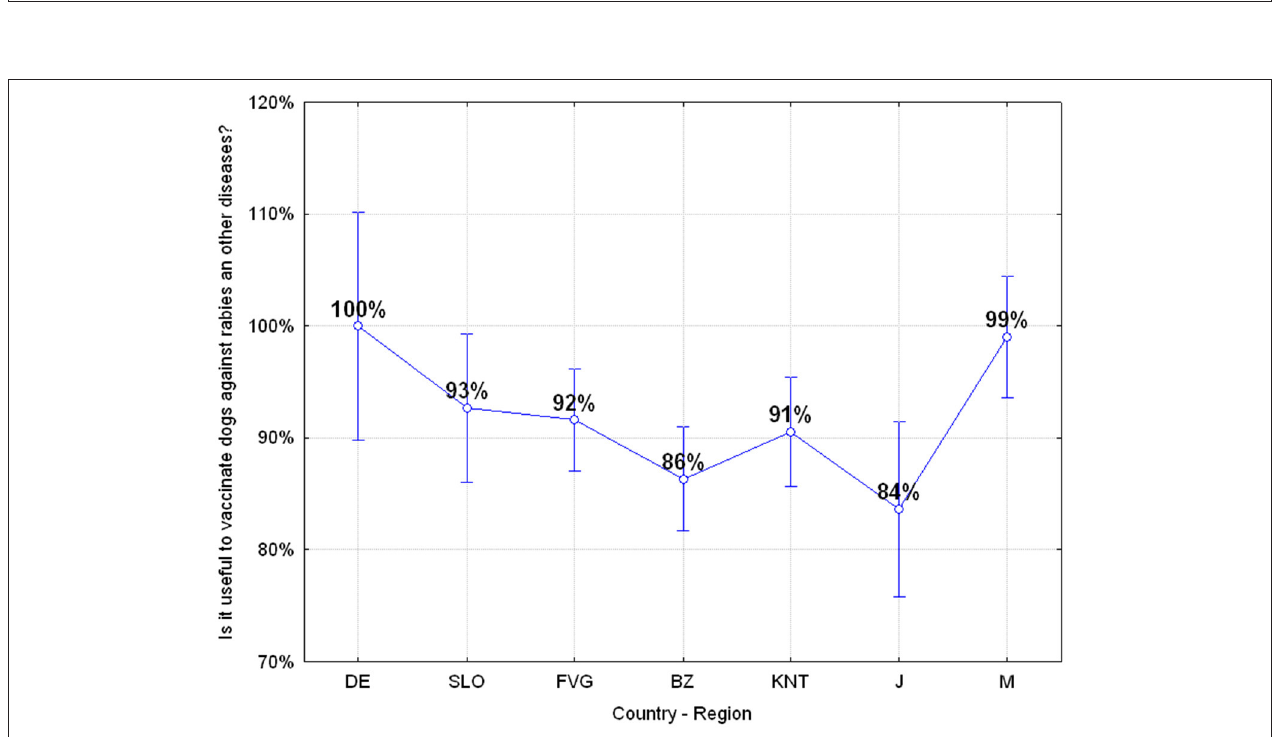
FIGURE 6 | Q20: “Must dogs be given medication against intestinal worms at least once a year?” ANOVA F (6,649) p = 0.00153 [Axes X regions or countries, Axes Y % correct answers–DE, Germany; SLO, Slovenia; FVG, Friuli Venezia Giulia Italy; BZ, Autonomous Province of Bolzano Italy; KNT, Carinthia Austria; J, Japan; M, Mauritius–( n = 656)].